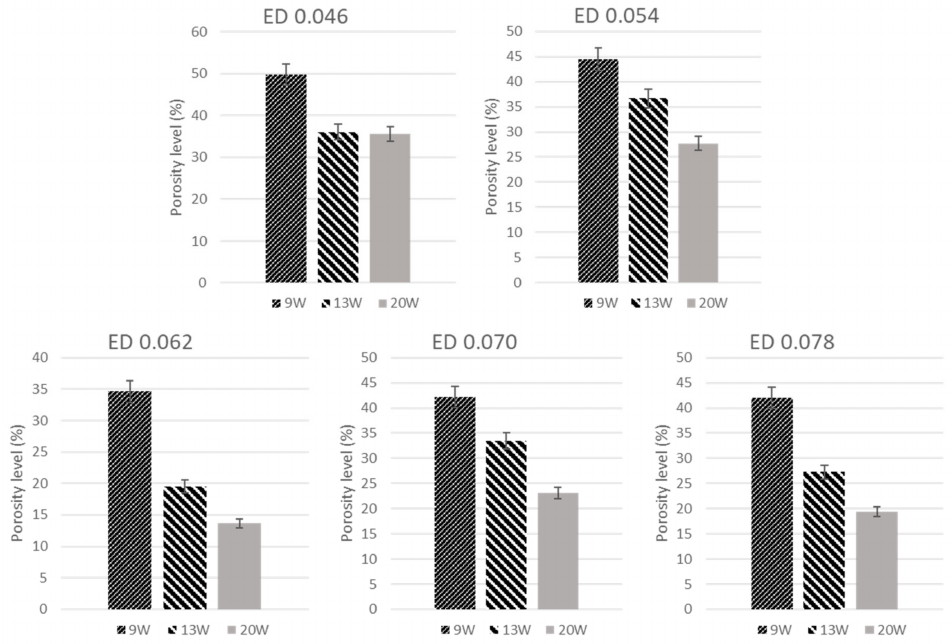
Figure 5. Porosity levels results of each processing parameter.